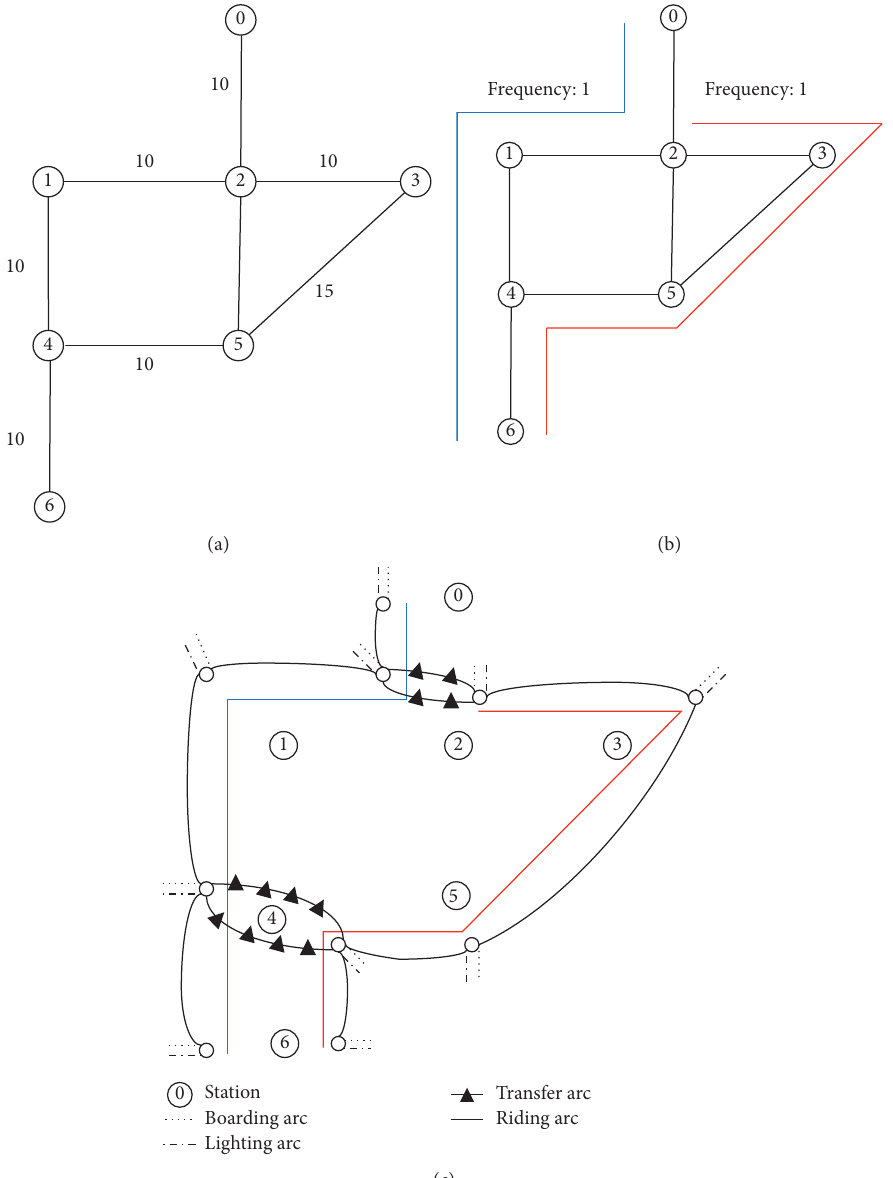
Figure 1: The infrastructure of the small example network (a); an example line plan with two lines (b); the corresponding TSN for this line plan